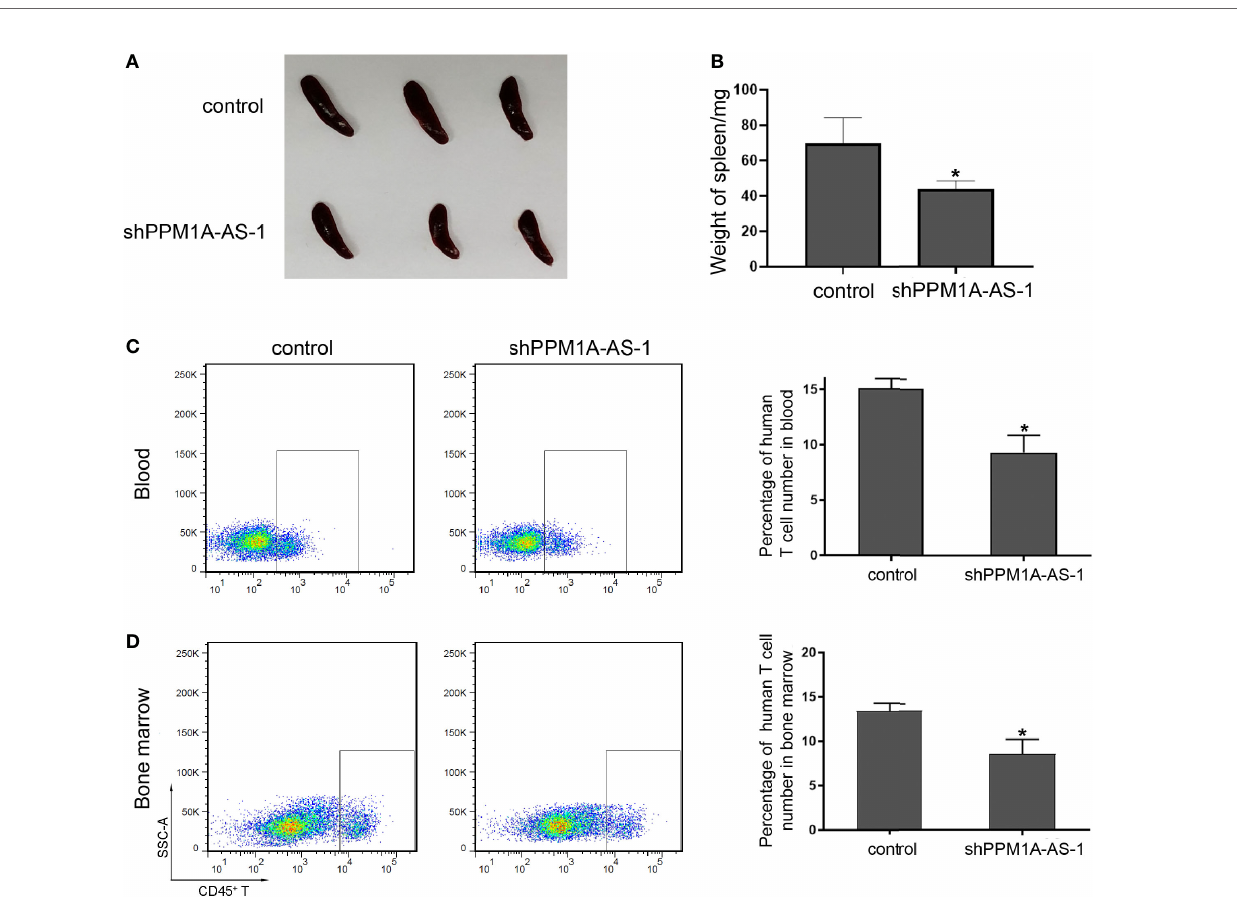
FIGURE 4 | LncRNA PPM1A-AS can enhance tumor development in NOD-SCID mice. Jurkat cells were infected with control or PPM1A-AS-overexpression lentivirus and transplanted mice by tail intravenous injection. About 45 days later, the mice were sacri fi ced, the photos were taken and relative data were detected. (A) Representative images of spleens from mice. (B) Quantitative analyses of the weights of the spleens. (C) Flow cytometry analyses of human CD45 + T cells in peripheral blood of mice. Left panel: representative images; right panel: average percentage of CD45 + T cells in peripheral blood from each mouse. (D) Flow cytometry analyses of human CD45 + T cells in bone marrow of mice. Left panel: representative images; right panel: average percentage of CD45 + T cells in bone marrow from each mouse. Mean ± SD. *P <